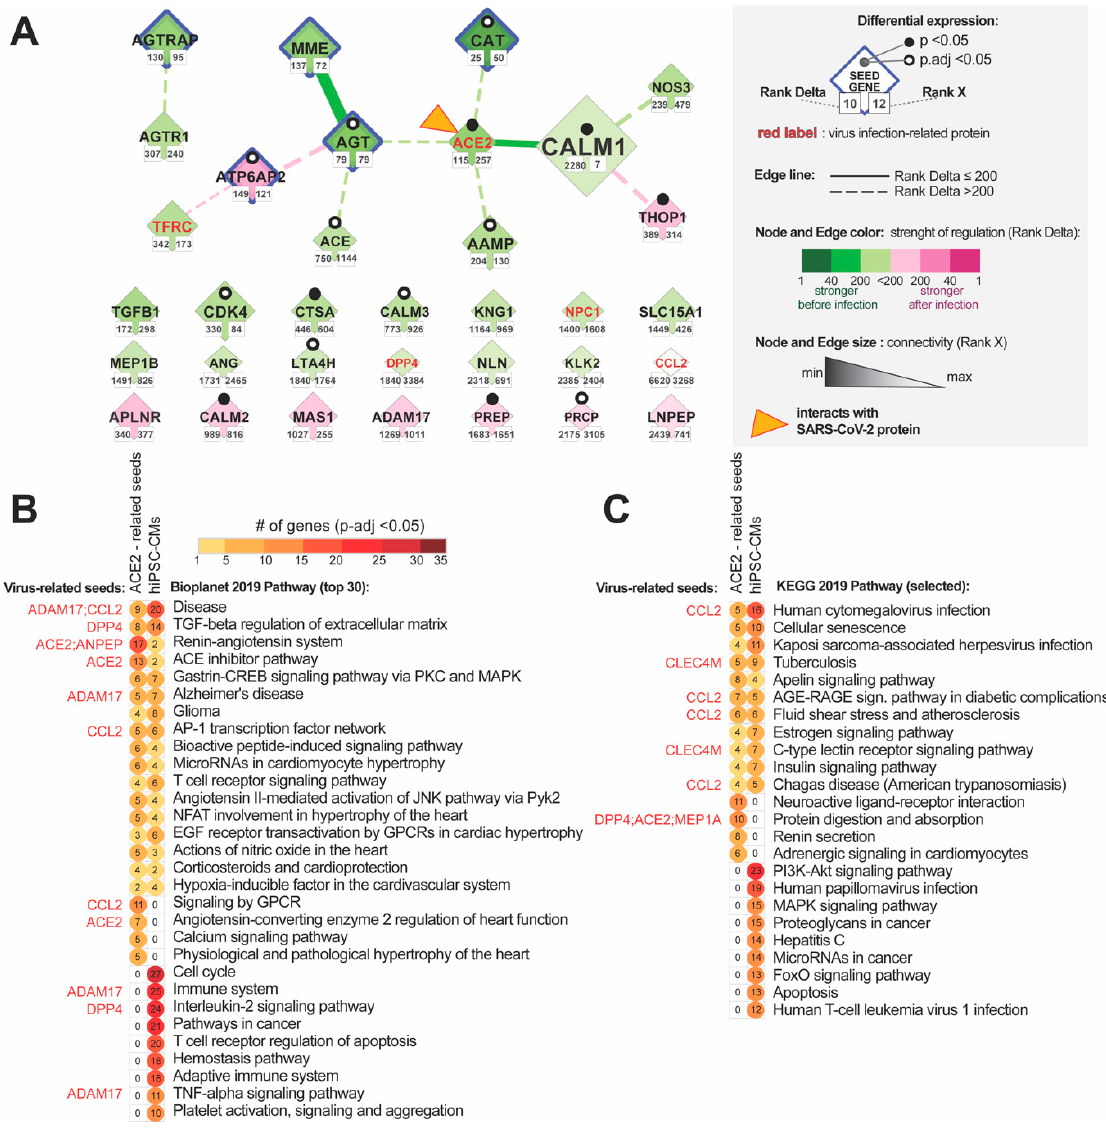
Figure 5. ACE2 (Angiotensin-Converting Enzyme 2) network in infected human-induced pluripotent stem cell-derived cardiomyocyte (hiPSC-CMs) and top signaling pathways enriched in ACE2 interaction networks. ( A ) ACE2 related genes identified using data mining and co-expression network in stem cell-derived cardiomyocytes (hiPSC-CMs) 72 h after infection. Pathway enrichment analysis of the complete ACE2 network (68 genes) and 139 top hub genes identified in ACE2 related co-expression network analysis for hiPSC-CMs. Notice that the strongest altered interaction was between AGT-MME (membrane metallo-endopeptidase) and ACE2 and CALM1 (Calmodulin 1), and the strongest affected nodes are AGT (Angiotensinogen) and CAT (Catalase). ( B ) Bioplanet database (top 30 pathways) and ( C ) KEGG database (additional pathways not present in Bioplanet). Virus-infection related proteins from the complete ACE2 network are marked with red font. All circles presented on the graph are associated with significantly enriched pathways (False Discovery Rate corrected p -value < 0.05). In this analysis, we also included ACE2-sub-networks for the heart, lungs, and nervous system, but due to high similarity with results for the complete ACE2 network, we excluded them from the figure for better clarity.